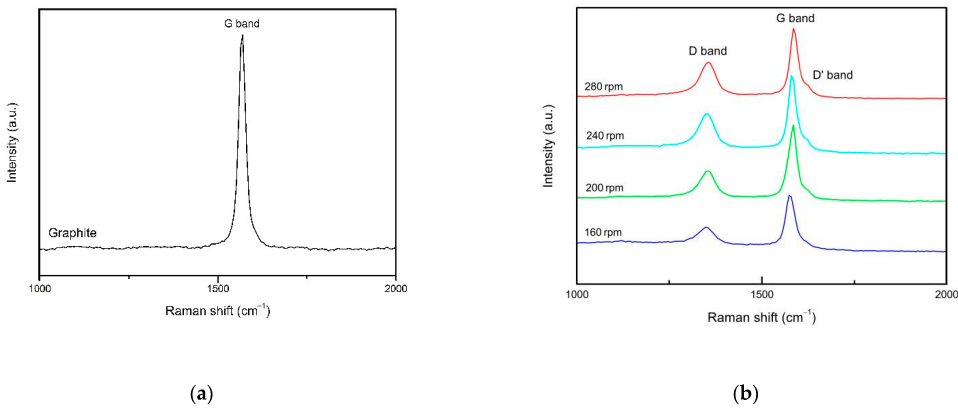
Figure 1. 1. Figure 10. Raman spectra of graphite and composite materials at different speeds: ( a ) Raman spectrum of the initial material graphite flakes; ( b ) Raman spectra of four composite materials at different rotational